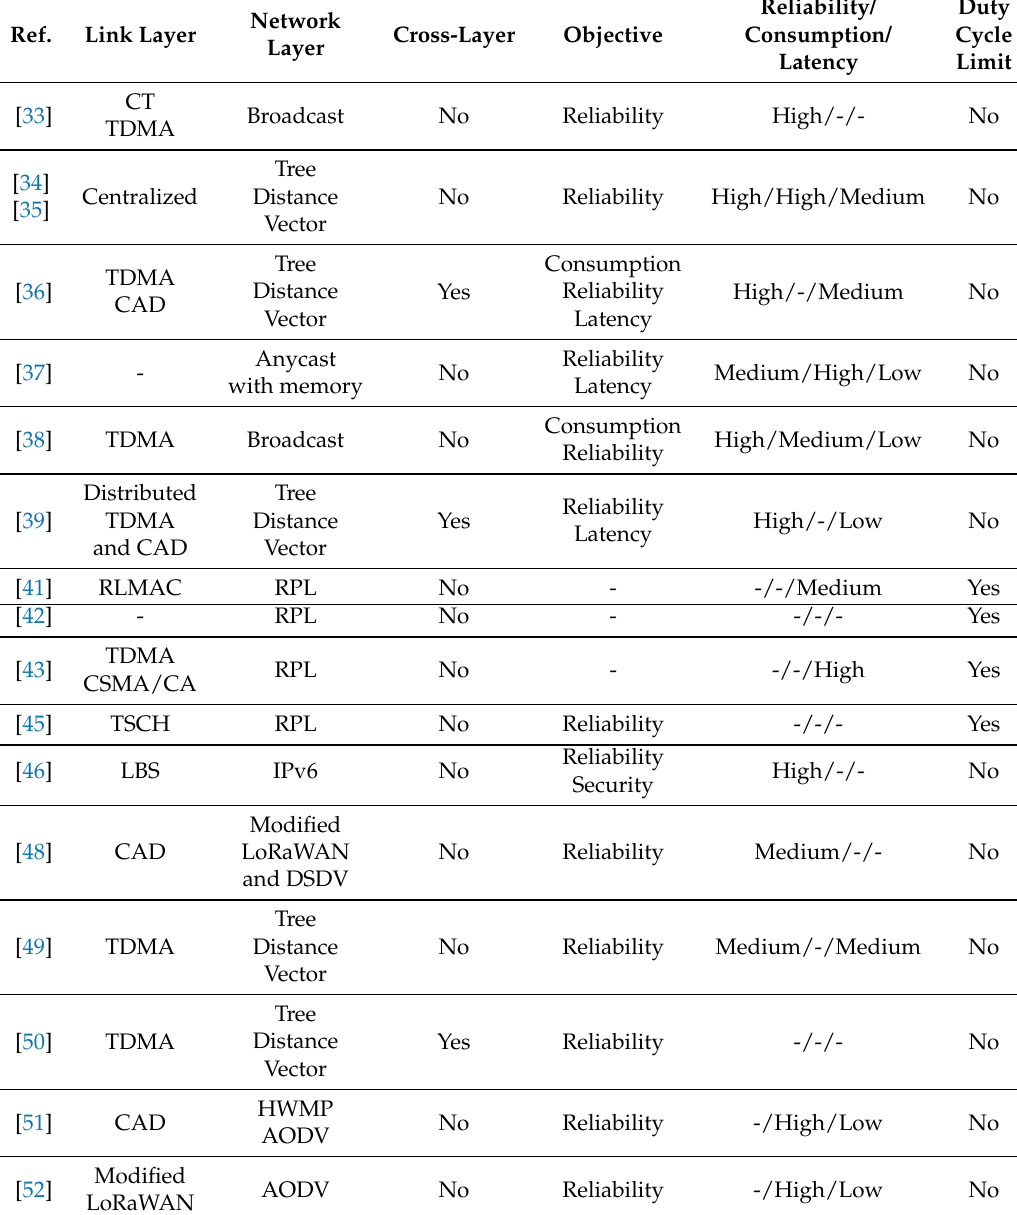
Table 1. Summary of the structure, main objectives and evaluation of the LoRa/LoRaWAN proposals.